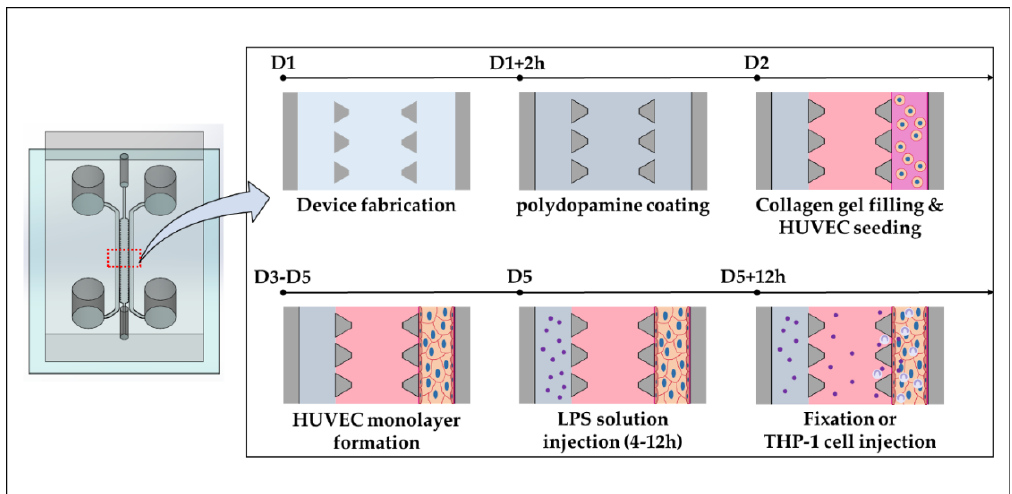
Figure 1. Schematic diagram of fabrication process for recreating blood vessel inflammation model in the microfluidic chip.